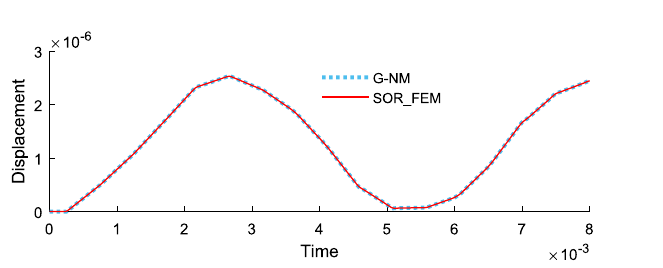
Figure 19. Time history of displacement at the region 2